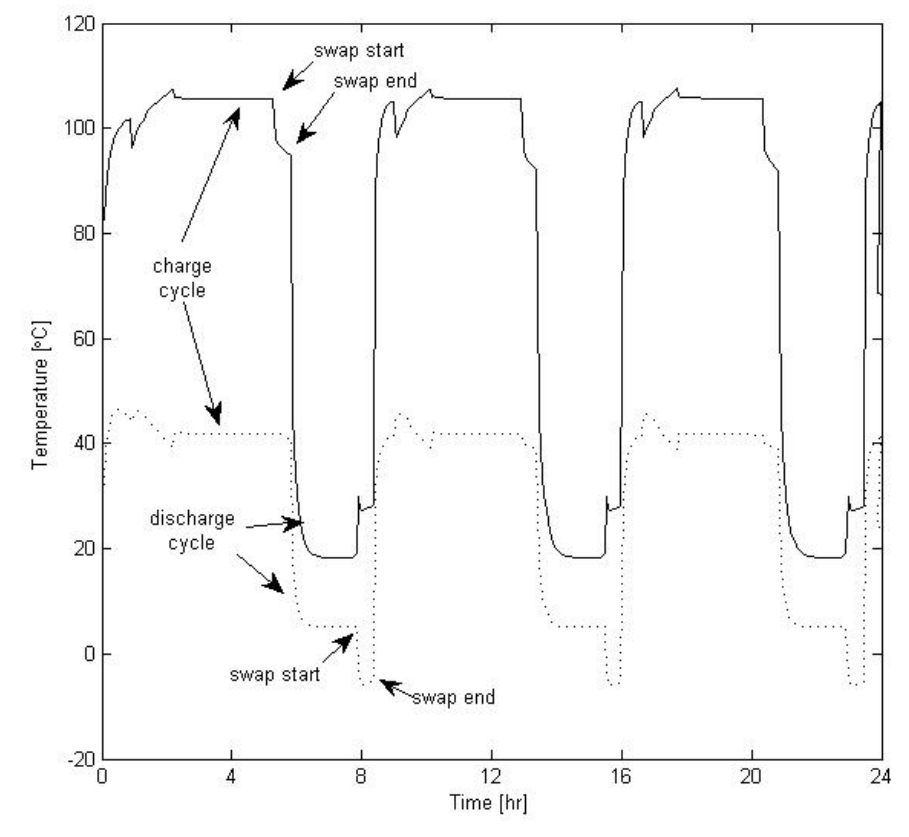
Figure 3. Outlet temperatures for condenser and